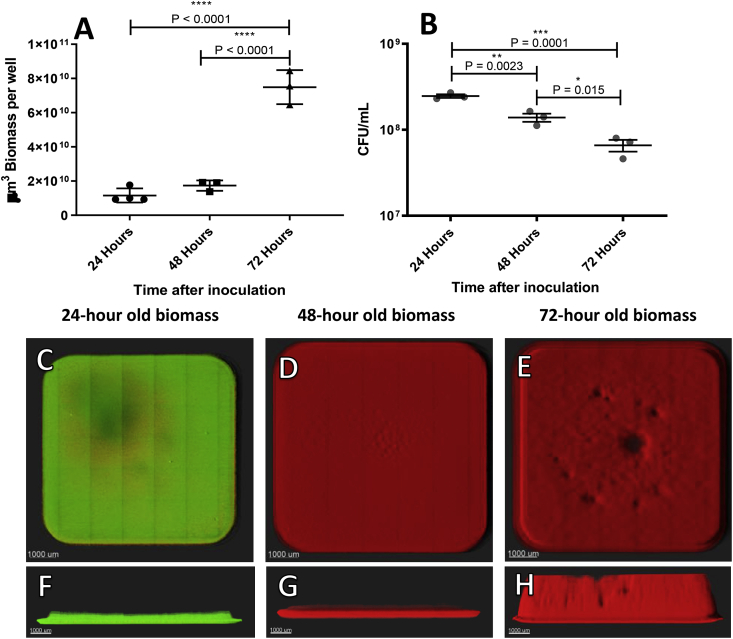
A) Quantitative measurements of undisturbed P. aeruginosa biomass in 24-, 48-, and 72-h old wells. There was significantly more biomass (μm [3]) in 72-h old wells than in 24- and 48-h old wells. B) CFU count from undisturbed wells at the three timepoints. C–E) 3D projections of undisturbed P. aeruginosa biomass stained with live/dead stain. F–H) Side view of P. aeruginosa biomass stained with live/dead stain.